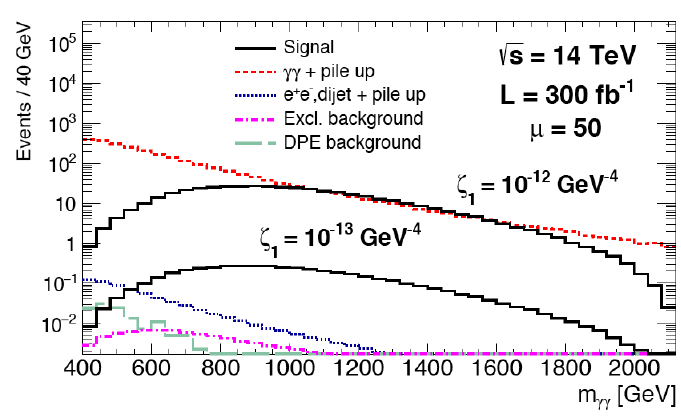
Figure 4: Number of events as a function of the diphoton mass for signal and back- ground for exclusive γγ production.